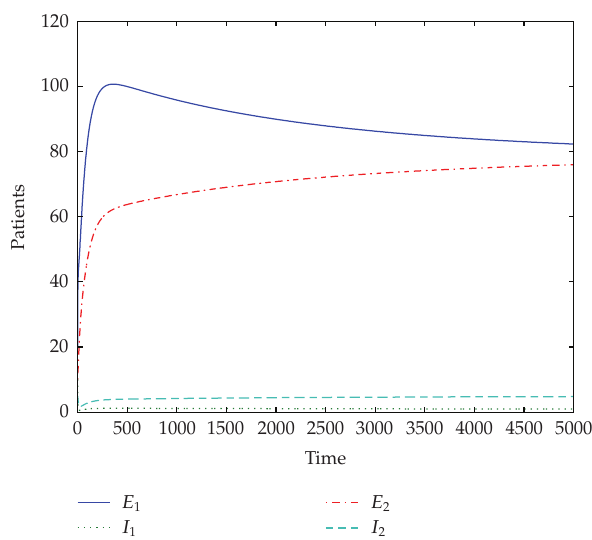
Figure 13: Trajectories of system (cid:2) 2.2 (cid:3) when β 1 (cid:2) N (cid:3) (cid:8) β 1 C (cid:2) N (cid:3) , β 2 (cid:2) N (cid:3) (cid:8) β 2 C (cid:2) N (cid:3) , C (cid:2) N (cid:3) (cid:8) N/ (cid:2) 1 (cid:9) N (cid:9) √ 1 (cid:9) 2 N (cid:3) , β 1 (cid:8) 1, β 2 (cid:8) 0 . 25, d 1 (cid:8) 0 . 02, d 2 (cid:8) 0 . 07, so that R 1 > H , R 2 < f (cid:2) R 1 (cid:3) . It shows that the interior equilibrium P 2 is